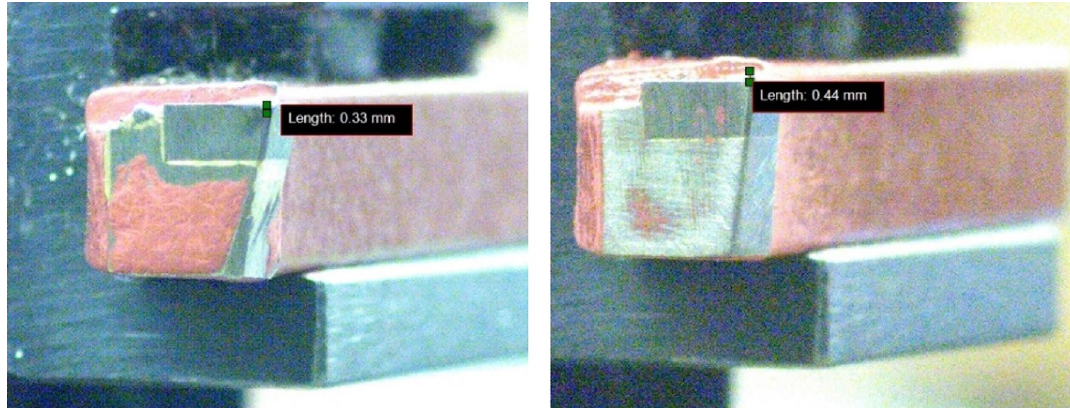
Fig. 8 Amount of wear measurement using IC Measure software